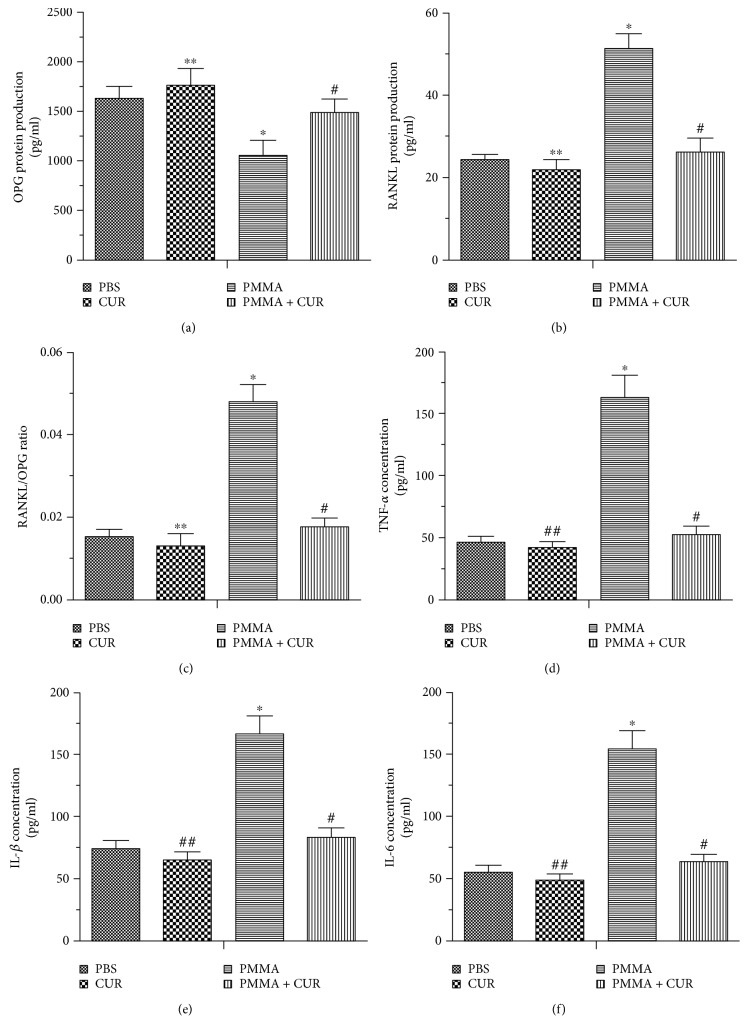
ELISA results for TNF-α, IL-1β, IL-6, OPG, RANKL protein levels, and the RANKL/OPG ratio in the supernatants of cultured calvaria (N = 6/group; ∗∗p > 0.05 versus the PBS group; ##p < 0.05 versus the PBS group; ∗p < 0.001 versus the PBS group; #p < 0.01 versus the PMMA group).